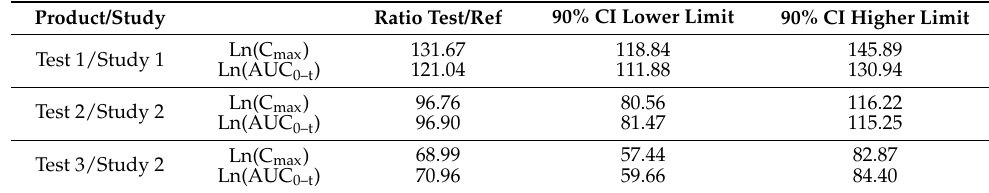
Table 1. Summary of the AUC and C max ratios from both BE studies.